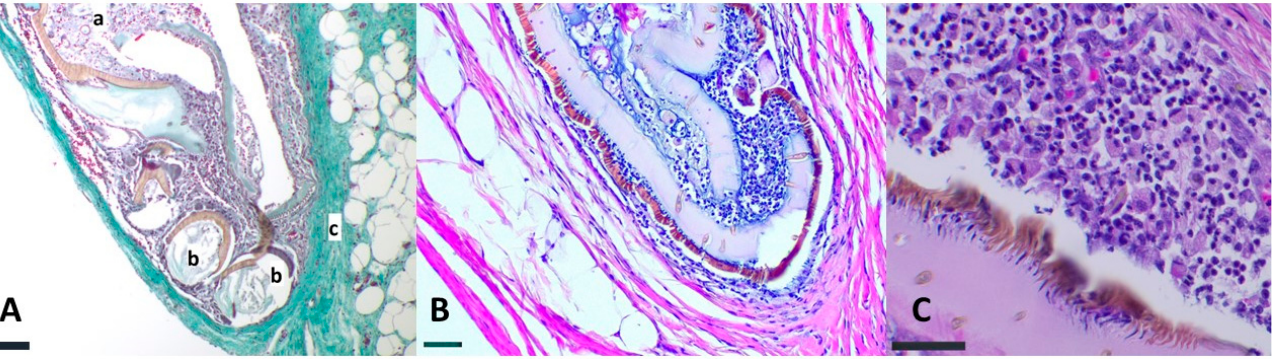
Figure 2. Histological sections of ticks in the SC tissue of red foxes from Italy. ( A ): moderate mixed infiltrate composed by neutrophils, lymphocytes and rare eosinophils surrounding the tick (a). Fragments of tick exoskeleton surrounded by inflammatory cells (b) and a complete multilayer connective tissue capsule surrounding the tick body (c) (Masson’s trichrome, bar 500 μ m). ( B ): The inner part of the tick was composed of cell debris and a multilayer connective tissue capsule surrounding the tick body (HE, bar 300 μ m). ( C ): mild mixed infiltrate surrounding the tick, and a thin connective tissue capsule (HE, 150 μ m).